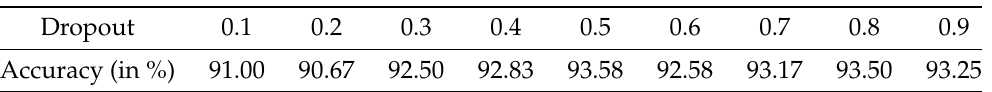
Table 9. Results obtained for different dropout values keeping batch size, image size, and epochs as 100, 100, and 150,